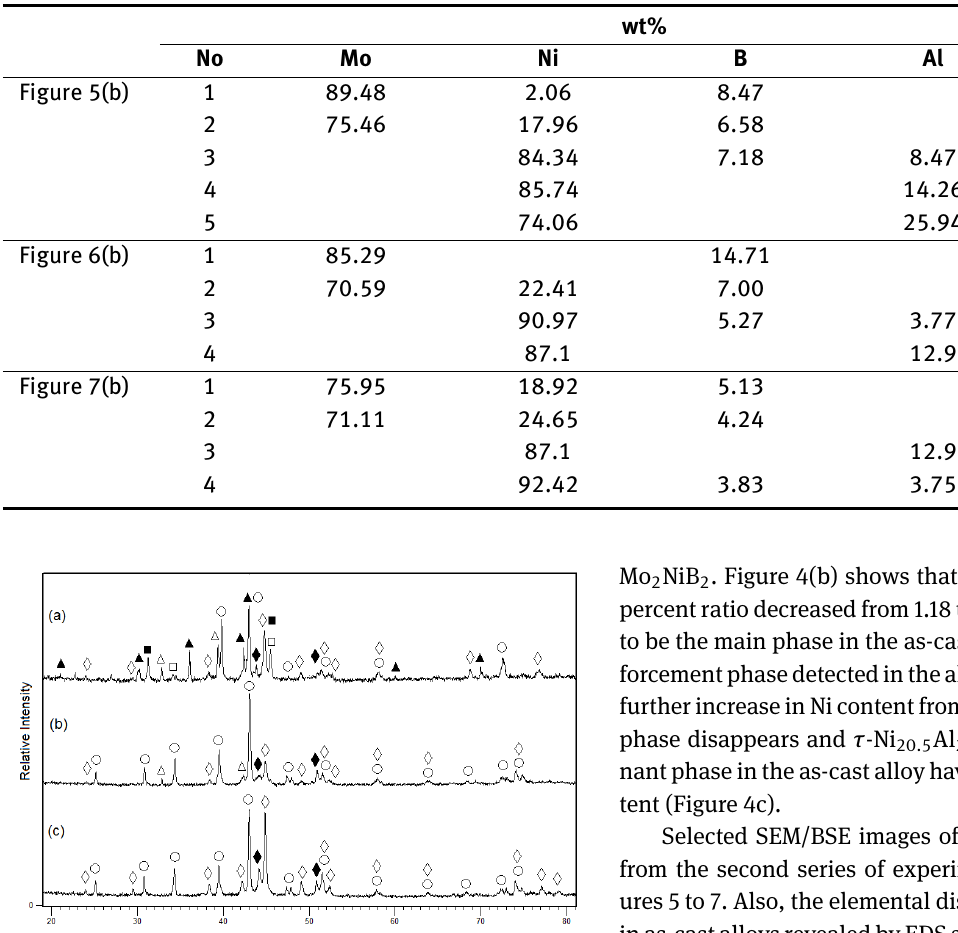
Table 5: The EDS measured elemental compositions for crystalline phases shown in Figures 5(b), 6(b) and 7(b).